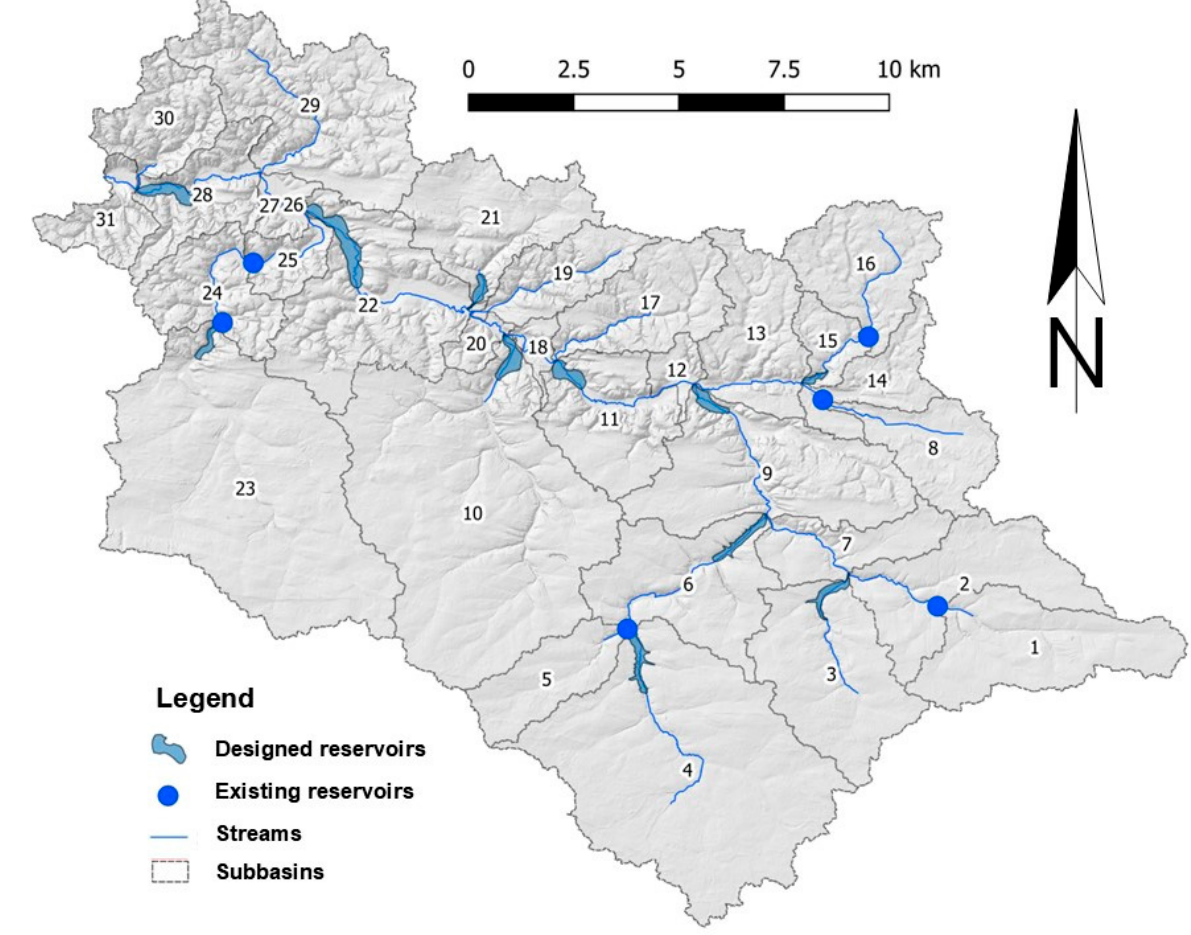
Figure 2. Bystra catchment area with modified or designed reservoirs for adaptation scenarios 1–5 for variant 3 (author’s own study).